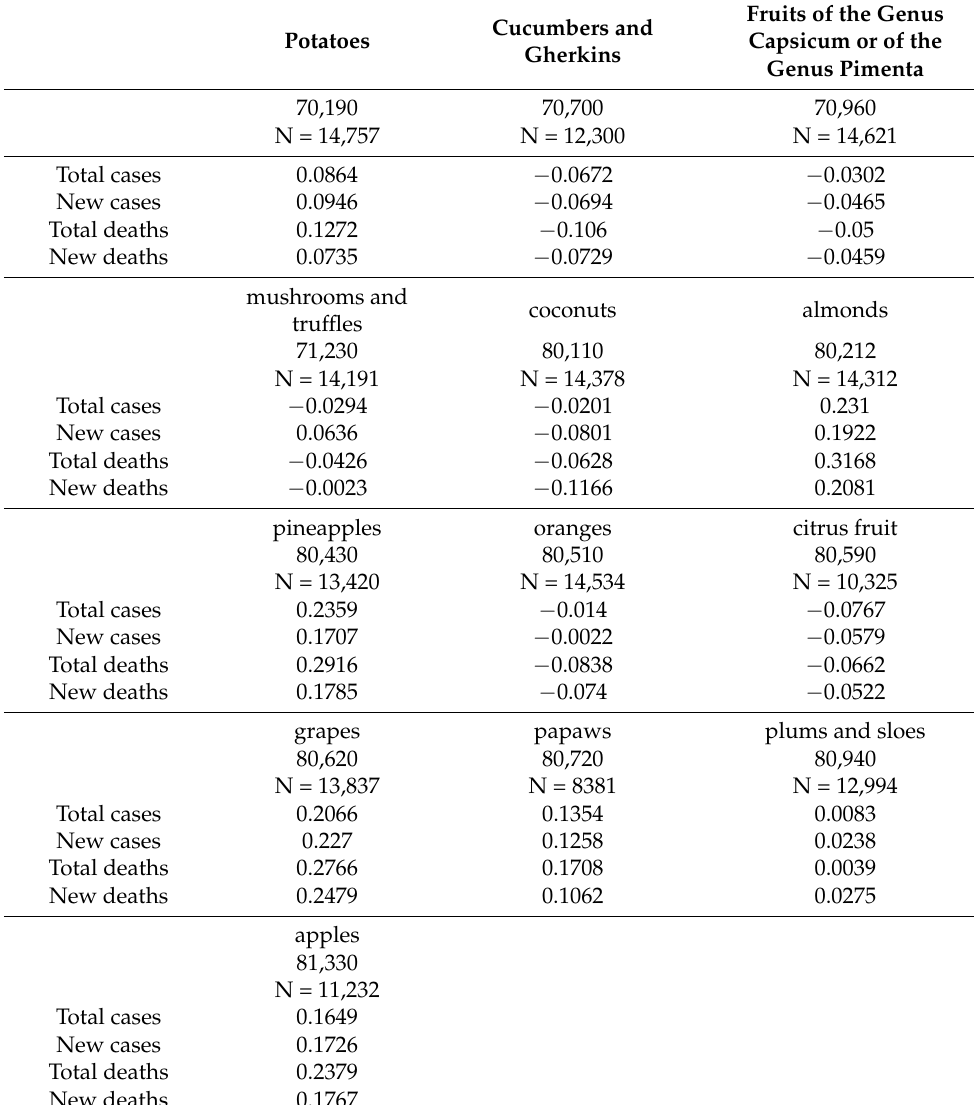
Table 2. Correlation tests between selected foods and COVID-19